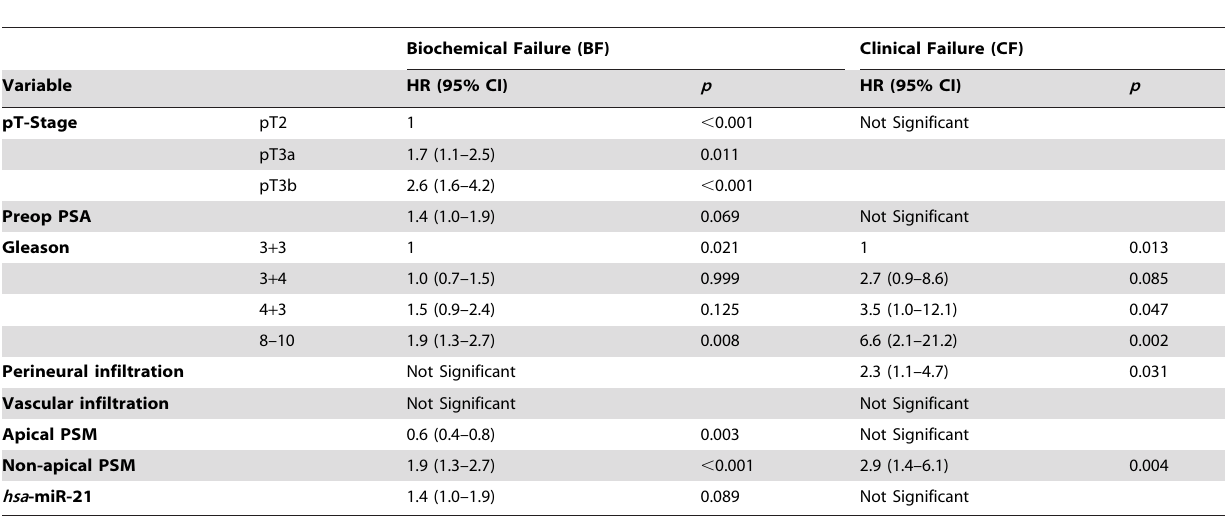
Table 4. Results of Cox regression analysis of significant independent clinicopathological actors and high tumour stromal expression of mir-21 versus BF and